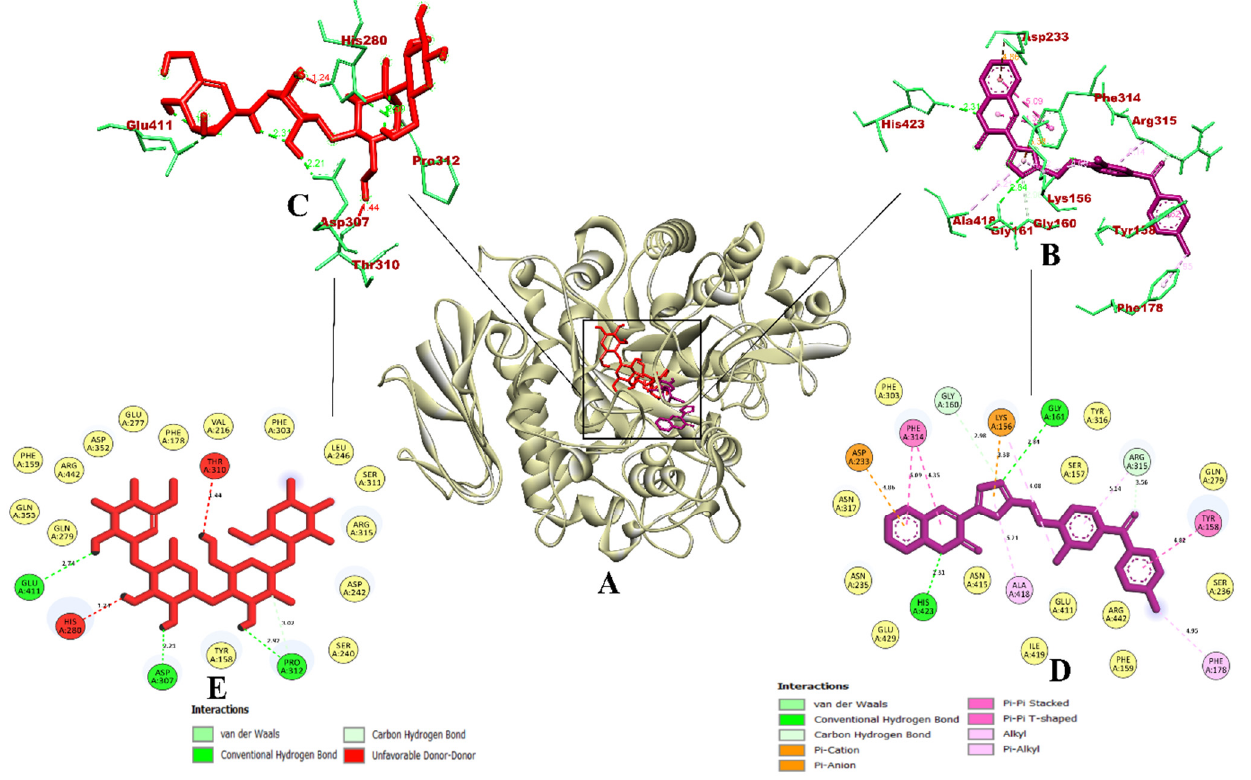
Figure 1. Visualization of binding interaction of CD-59 (violet) and acarbose (red) with α -glucosidase; ( A ) 3D structure of α -glucosidase with bound CD-59 and acarbose in the binding pocket, ( B ) 3D representation of CD-59 binding interactions, ( C ) 3D representation of acarbose binding interactions, and ( D ) 2D representation of CD-59 binding interactions, and ( E ) 2D representation of acarbose binding interactions. Colored: bound residues, yellow: surrounding residues.